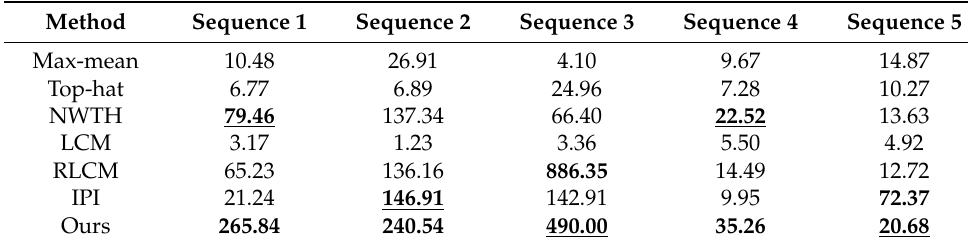
Table 3. Average SCR (notation: best result, second-best result).